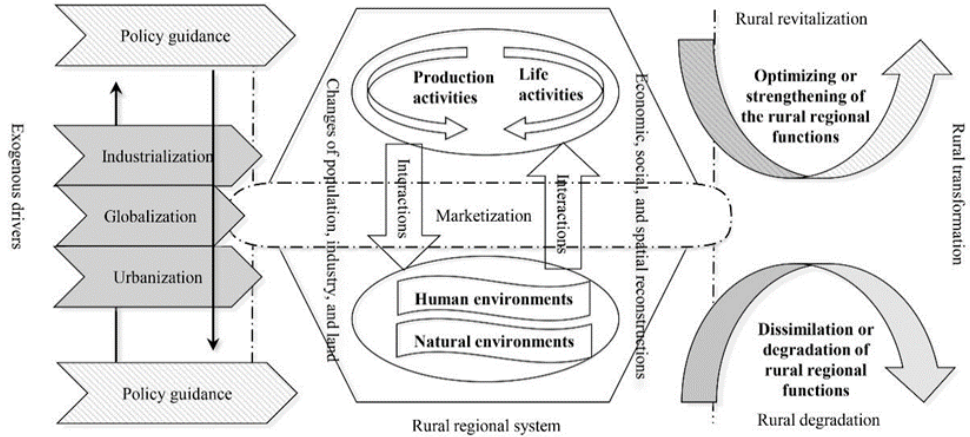
Figure 1. Framework of rural reconstruction — transformation — revitalization from a geography perspective. Note: On the left side, the upward arrow represents policy guidance to activate and amplify the positive effects, while the downward arrow represents policy guidance to shield and filter the negative effects.